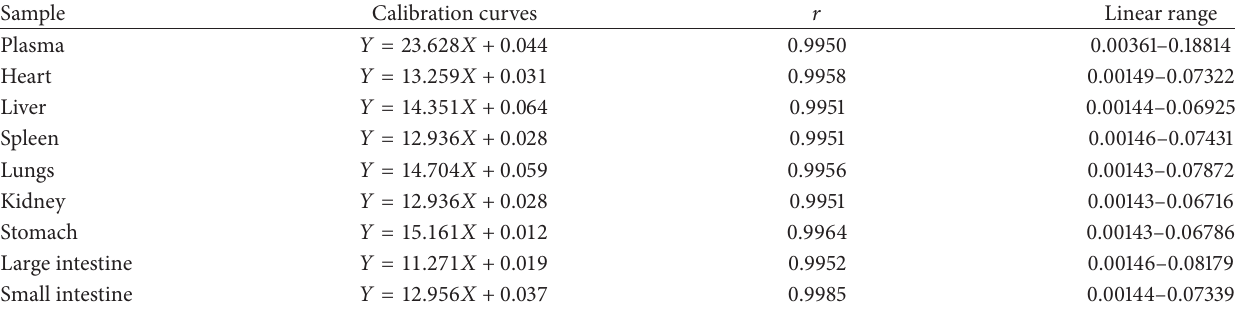
Table 1: The Linear regression analysis of (4 E ,6 E ,12 E )-tetradecatriene-8,10-diyne-1,3-diyl diacetate in rat plasma and tissues ( 𝑛 = 7